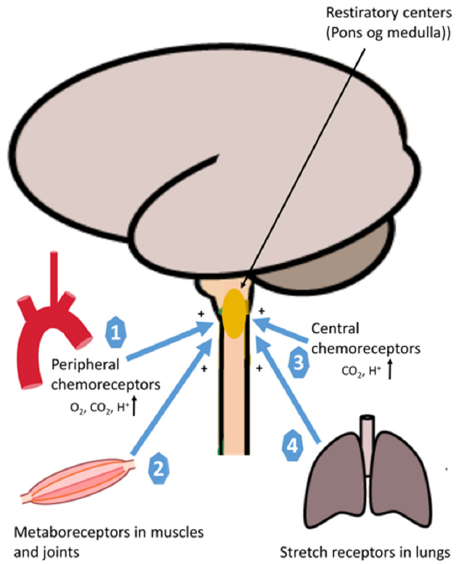
Figure 2. An illustration of neural regulation of ventilation during exercise. Peripheral chemoreceptors monitor the partial pressure of arterial O 2 in blood in response to acidosis (H + ) and carbon dioxide (CO 2 ) (1), Metaboreceptors stimulate breathing during exercise (2), Central chemoreceptors monitor the partial pressure of arterial O 2 in blood, pH, and carbon dioxide (CO 2 ) (3), Mechanoreceptors via spindles in the respiratory muscles (intercostal and diaphragm) measure the muscle length and increase the motor discharge (4).